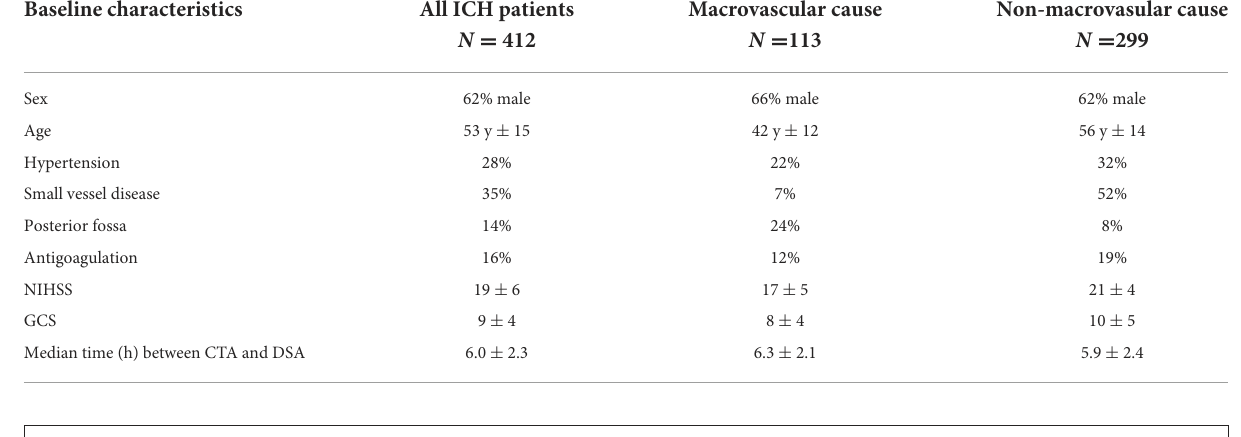
TABLE 1 Baseline characteristics.